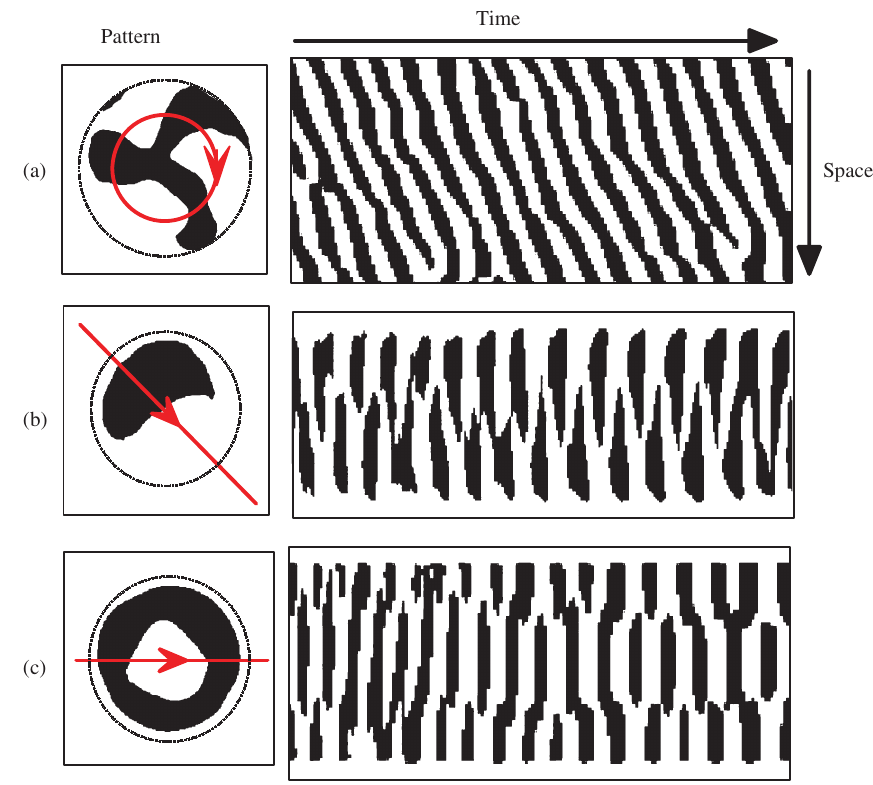
Fig. 10. Oscillation patterns observed in a particle model of Physarum polycephalum constrained within a circular well. Left: Snapshot of pattern with trajectory of space time plot overlaid, Right: Space time plot of oscillation pattern. a) Rotational pattern, b) Bilateral pattern, c) Annular